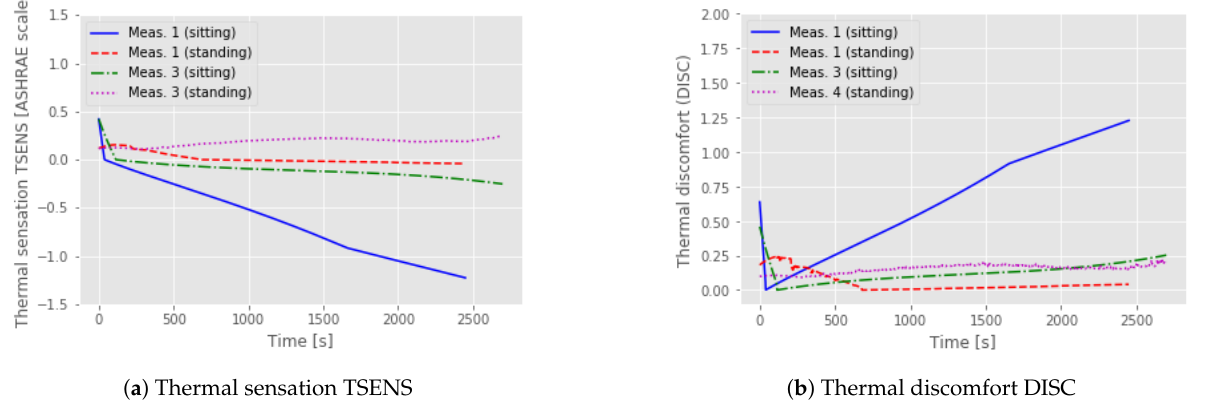
Figure 10. Computed ( a ) thermal sensation TSENS and ( b ) thermal discomfort DISC for Meas. 1 and Meas. 3 and for both sitting and standing test